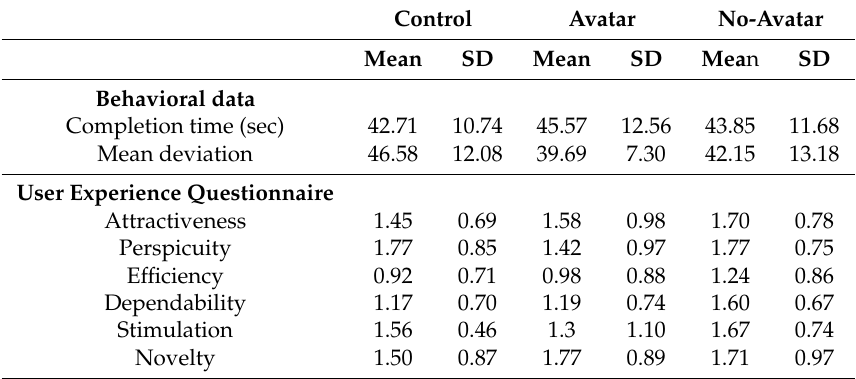
Table 2. Means (SD) across three experimental conditions on the behavioral and user experience questionnaire measures.